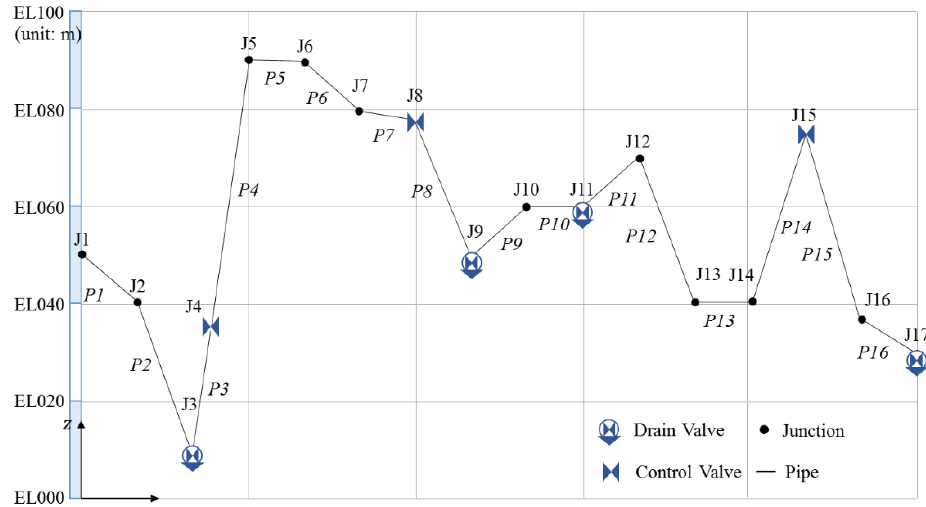
Figure 3. Network representation of a sample water transmission line.